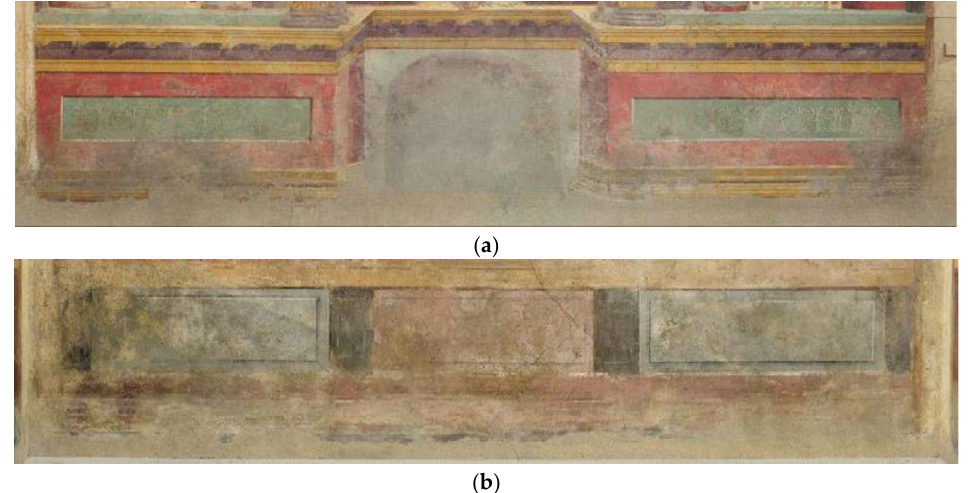
Figure 3. Details of dados from Figure 2: inset panels on side walls ( a ) vs. projecting on the end wall ( b ). Source: see Figure 2.